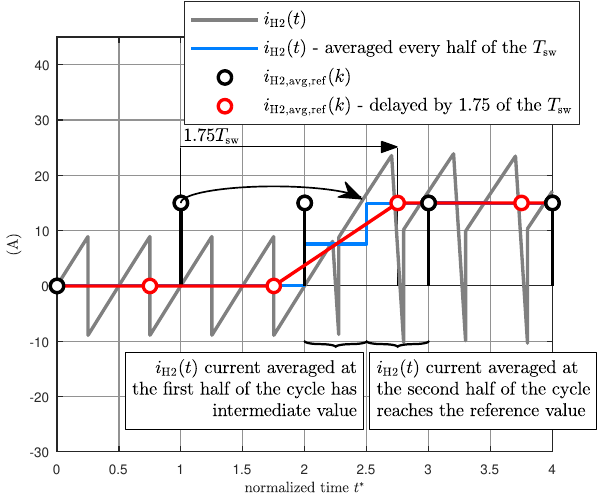
Figure 4. Exemplary simulation results illustrating the proposed modelling method.